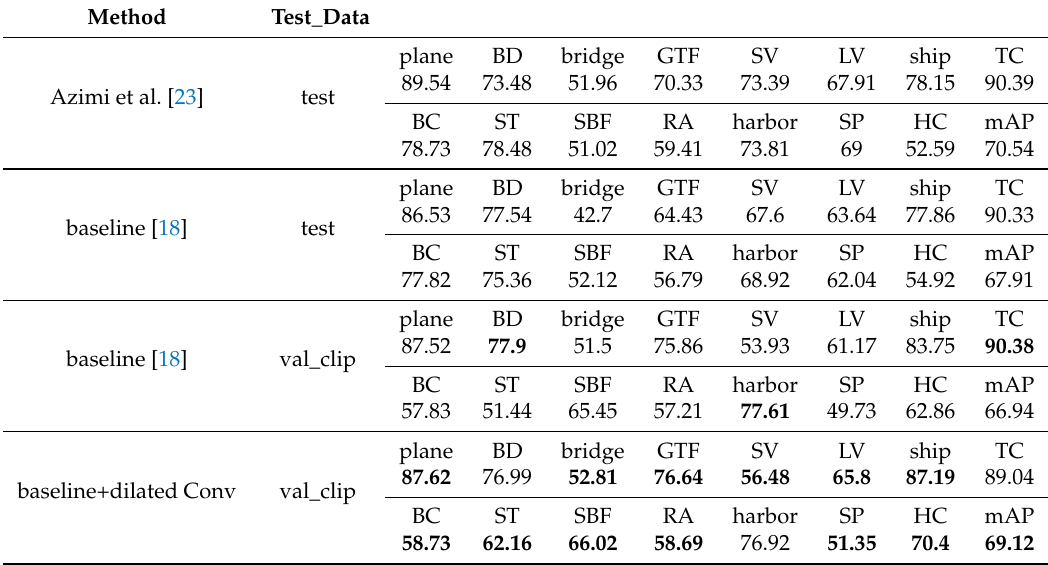
Table 3. Quantitative comparison of the baseline and other methods on DOTA dataset We highlight in bold the best results on each